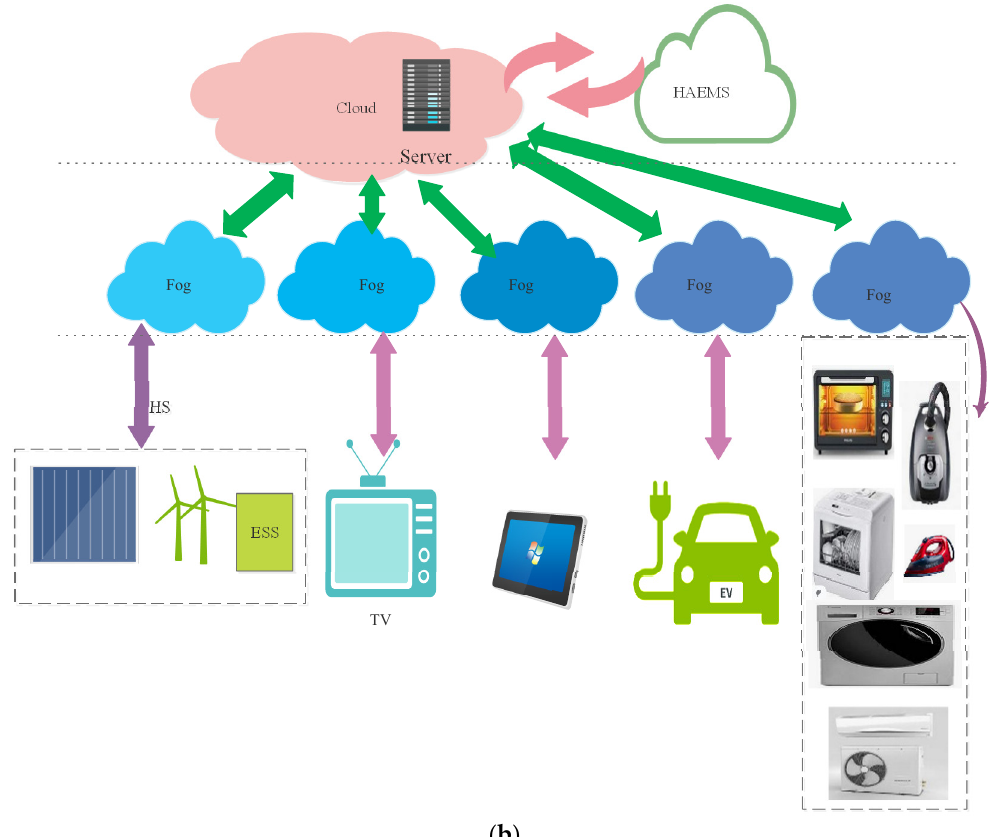
Figure 1. The system under study: ( a ) smart home and appliances; ( b ) cloud computing architecture for HAEMS .